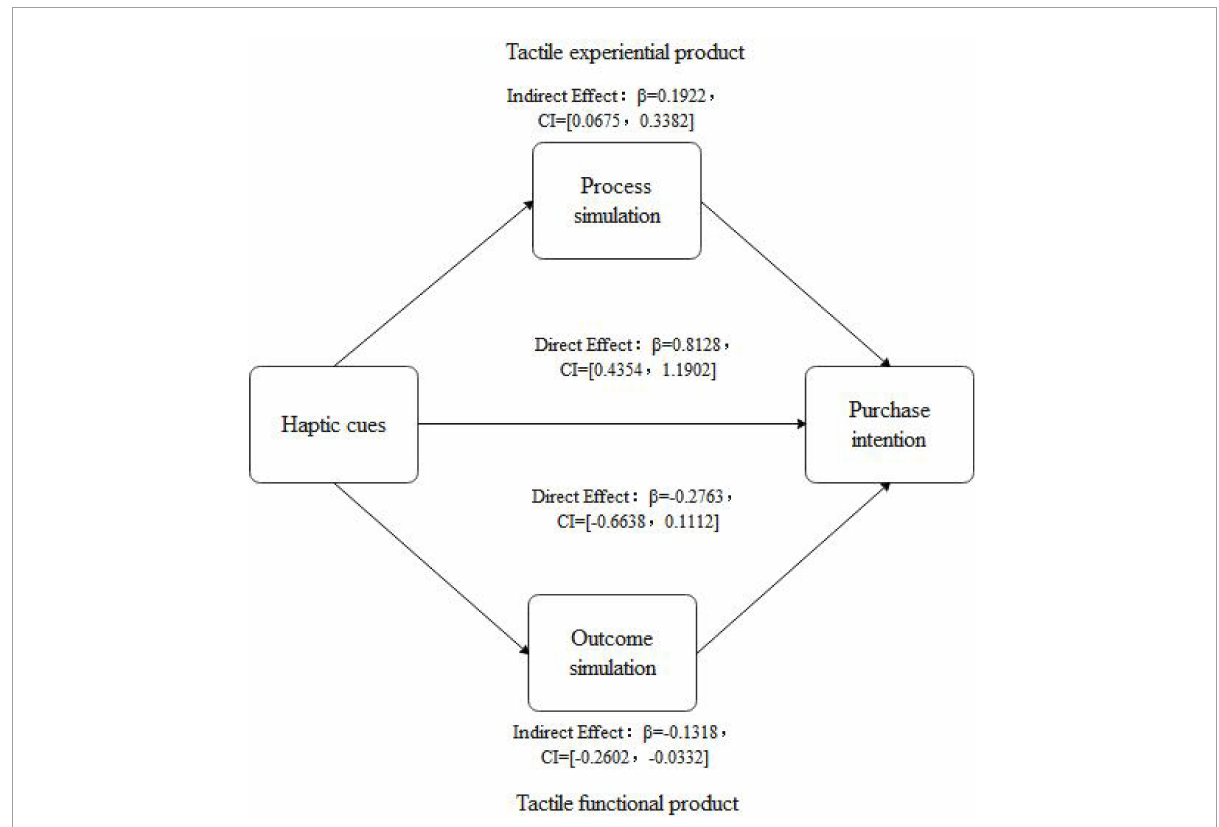
FIGURE6 Mediating effect of process simulation (tactile experiential product) and outcome simulation (tactile functional product).